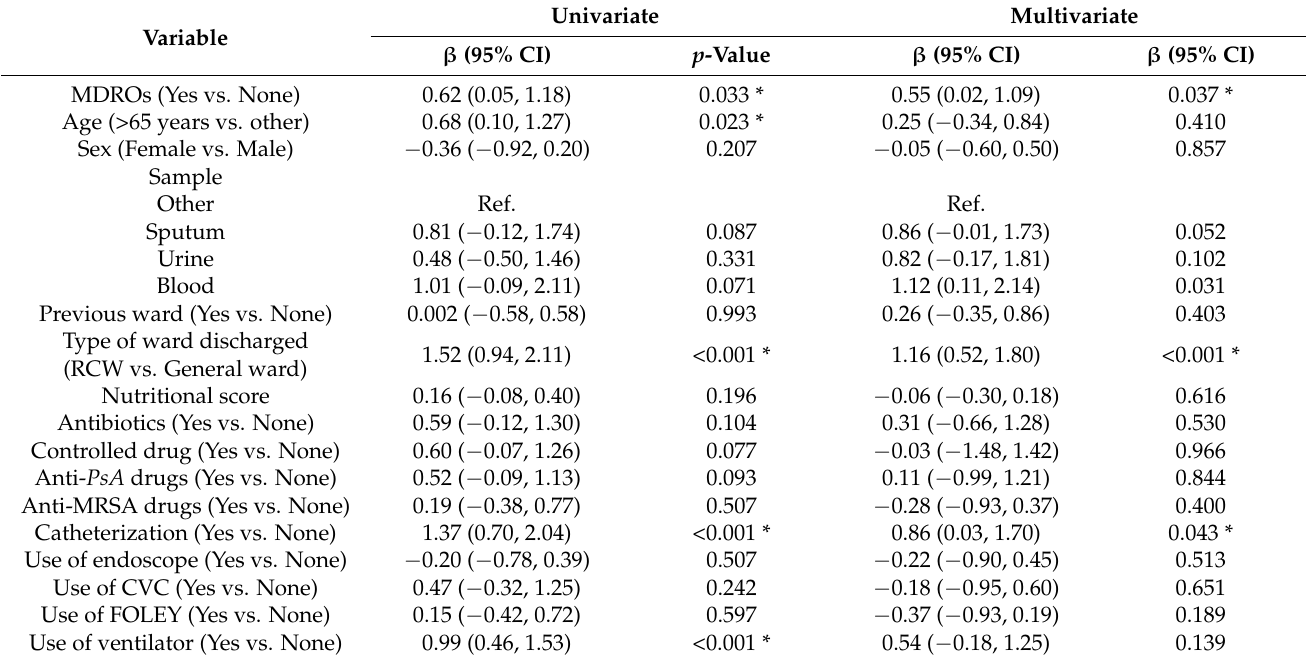
Table 2. Factors affecting the length of hospital